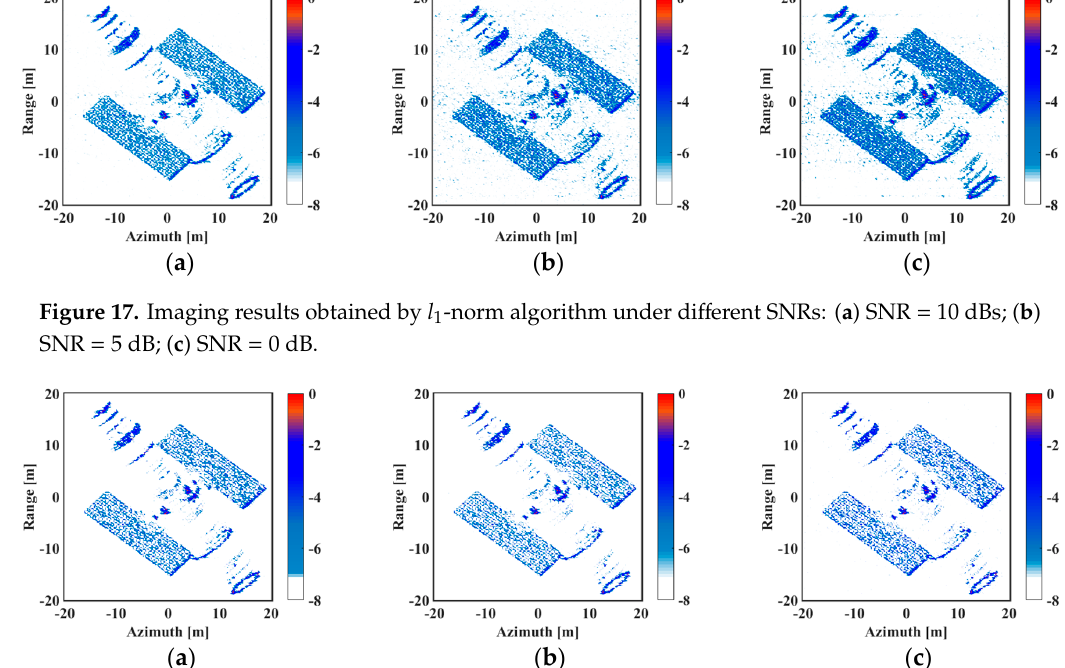
Figure 18. Imaging results obtained by the proposed algorithm under different SNRs: ( a ) SNR = 10 dB; ( b ) SNR = 5 dB; ( c ) SNR = 0 dB.